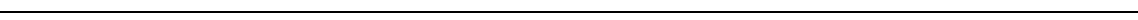
Fig. 2 Identi fi cation of miR-327 and FGF10 as SVF-derived modulators of early browning. a Heatmap of signi fi cantly ( P < 0.05) up- and downregulated miRNAs from 3-day CL-316243-treated visWAT-SVFs compared to vehicle-treated controls ( n = 5 mice per sample; n = 2 samples per group). b Heatmap of signi fi cantly downregulated growth factor (GF)-targeting miRNAs extracted from a . c – f qPCR analysis of miR-327 in c , d 3-day CL-316243-treated SVFs or e , f 1-week 4 °C-treated SVFs of scWAT, visWAT, and iBAT compared to respective controls. Sno-202 served as an internal control ( n = 5 samples per group). g Alignment details of miR-327 to Fgf10 3 ′ UTR binding site 1 (bs1) and binding site 2 (bs2). Xs mark nucleotides in bs1 and bs2 that were mutated to generate Mut-bs1 and Mut-bs2. h Quanti fi cation of Renilla luciferase activity normalized to Fire fl y luciferase activity in miR-327 mimic-treated HEK293T cells co-transfected with psiCHECK-2 vector, psiCHECK-2- Fgf10 bs1, psiCHECK TM -2- Fgf10 bs2, psiCHECK TM -2- Fgf10 Mut-bs1, or psiCHECK TM - 2- Fgf10 Mut-bs2 ( n = 5 samples per group). i Volcano plot of the FGF ligand and receptor families from genome-wide microarray analysis of 3-day CL- 316243-treated visWAT-SVF. Lowest P -value is highlighted in red and highest fold-change is highlighted in blue ( n = 4 mice per sample; n = 3 samples per group). j – m qPCR analysis of Fgf10 in j , k 3-day CL-316243-treated SVF or l , m 1-week 4 °C-treated SVF of scWAT, visWAT, and iBAT compared to respective controls ( n = 5 samples per group). NS, not signi fi cant. * P < 0.05, ** P < 0.01, and *** P < 0.001 by Student ’ s t -test. Data presented as mean ±